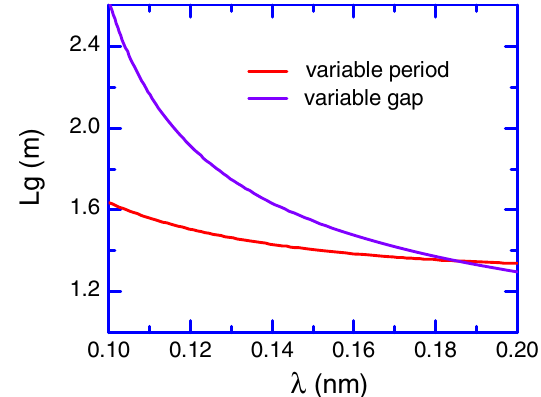
FIG. 11. The dependence of the gain length on the radiation wavelength.